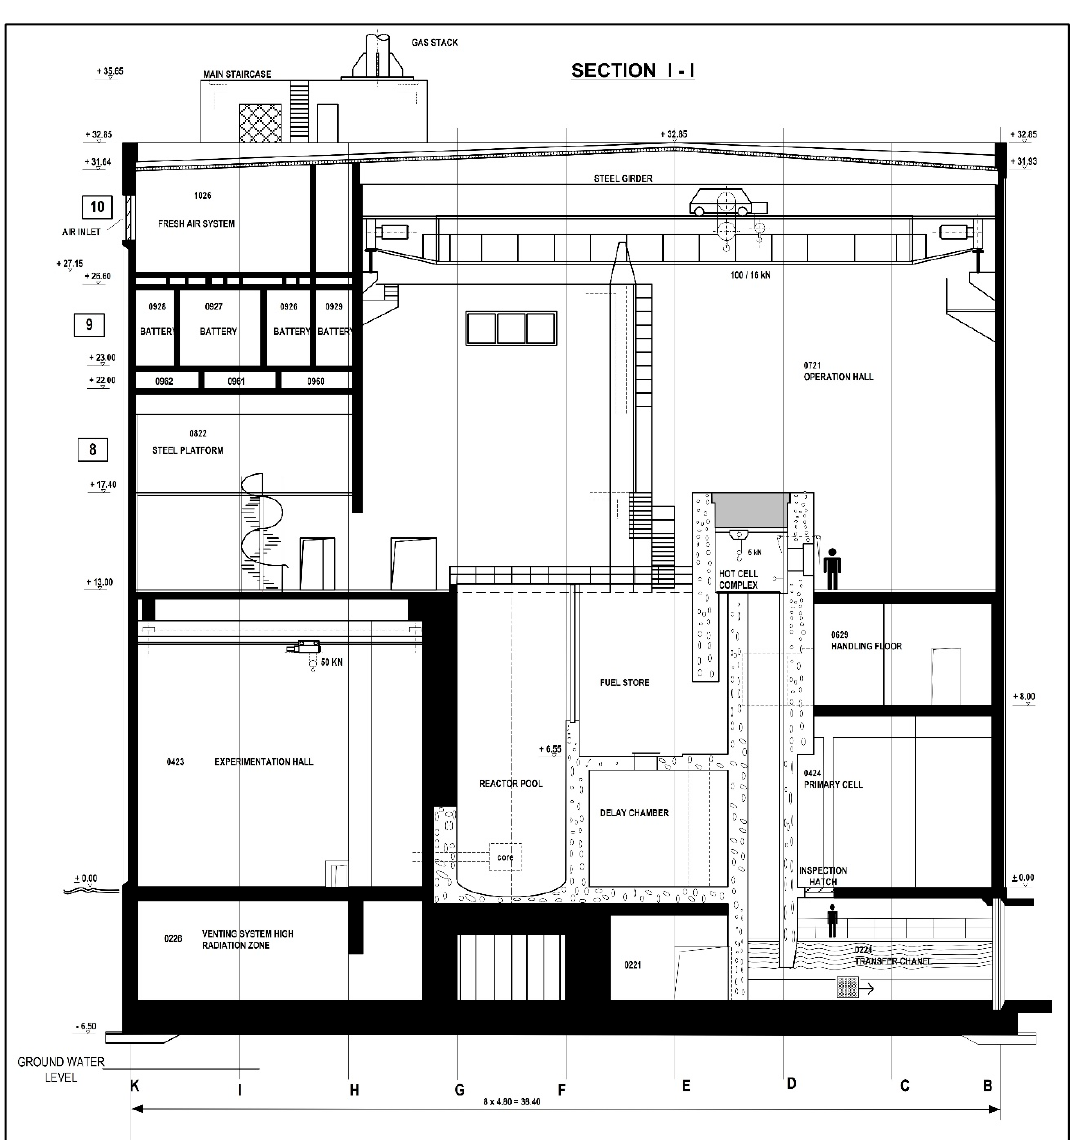
Figure 1. Reactor building cross-section [31].